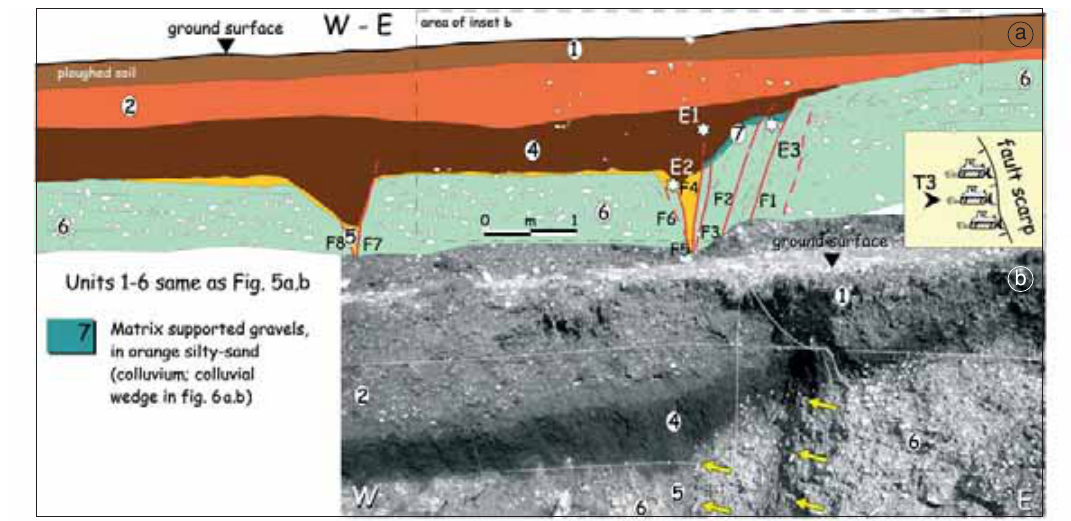
Fig. 7a,b. a) Log of the N wall of trench 3 excavated across the Prate Pala fault scarp (Mt. Vettore Fault); units are the same of fig. 5a,b; the paleoseismological analysis defined the occurrence of three displacement events. b) Panoramic view of trench 3 (N